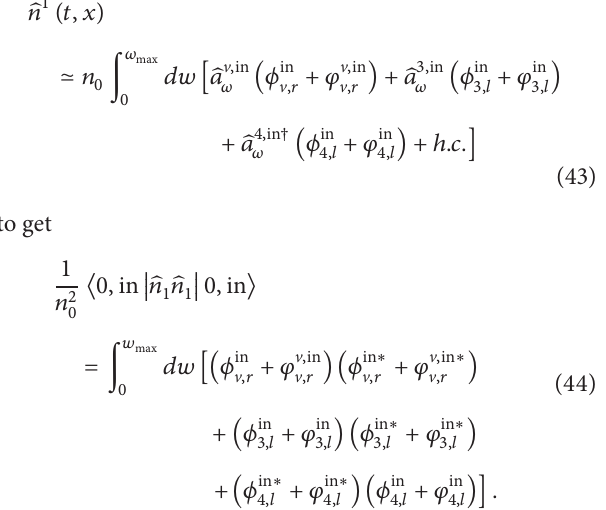
𝑐 )𝑒 −𝑖(𝑐 fin +𝑐 𝑟 )𝑘 󸀠 𝑡 0 𝑟 fin